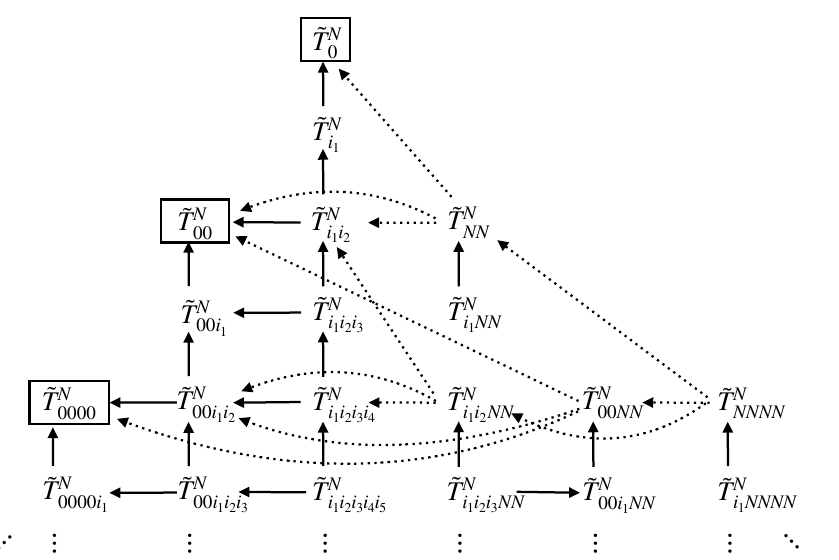
Figure 3 . Schematic roadmap for PV reduction of N -point FVC tensor coefficients. The solid and dashed lines stand for the recursive applications of eq. (3.31) and eq. (3.33), respectively. The boxed tensor coefficients are taken as the